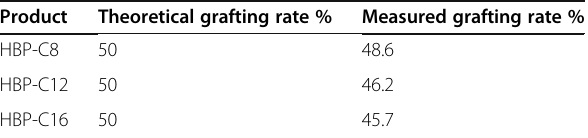
Table 1 The grafting rate of HBP-C Product